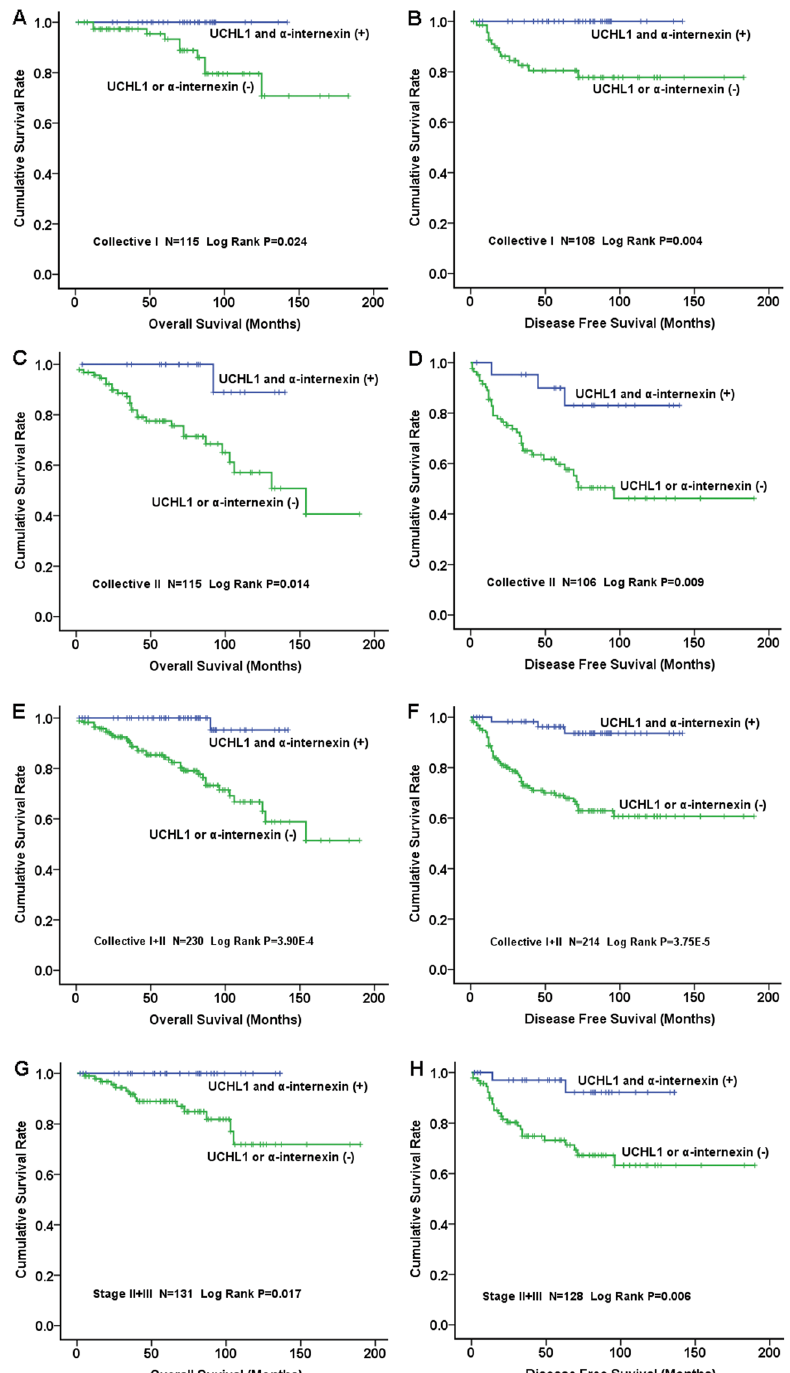
Figure 4. Correlation of Simultaneous Expression of UCH-L1 and α -internexin with Prognosis in 2 Collectives of Patients. Left panel: overall survival; right panel: disease free survival. The simultaneous expression of UCH- L1 and α -internexin in tumors was correlated with better overall survival and disease free survival in collective I ( A and B , respectively) and a better overall survival with a statistical trend in collective II ( C ) and favorable disease free survival in collective II ( D ) as well as in the combination of collective I + collective II ( E and F ). The expression of both proteins in tumors was significantly associated with favourable overall survival ( G ) and disease free survival ( H ) in patients with stage II and III